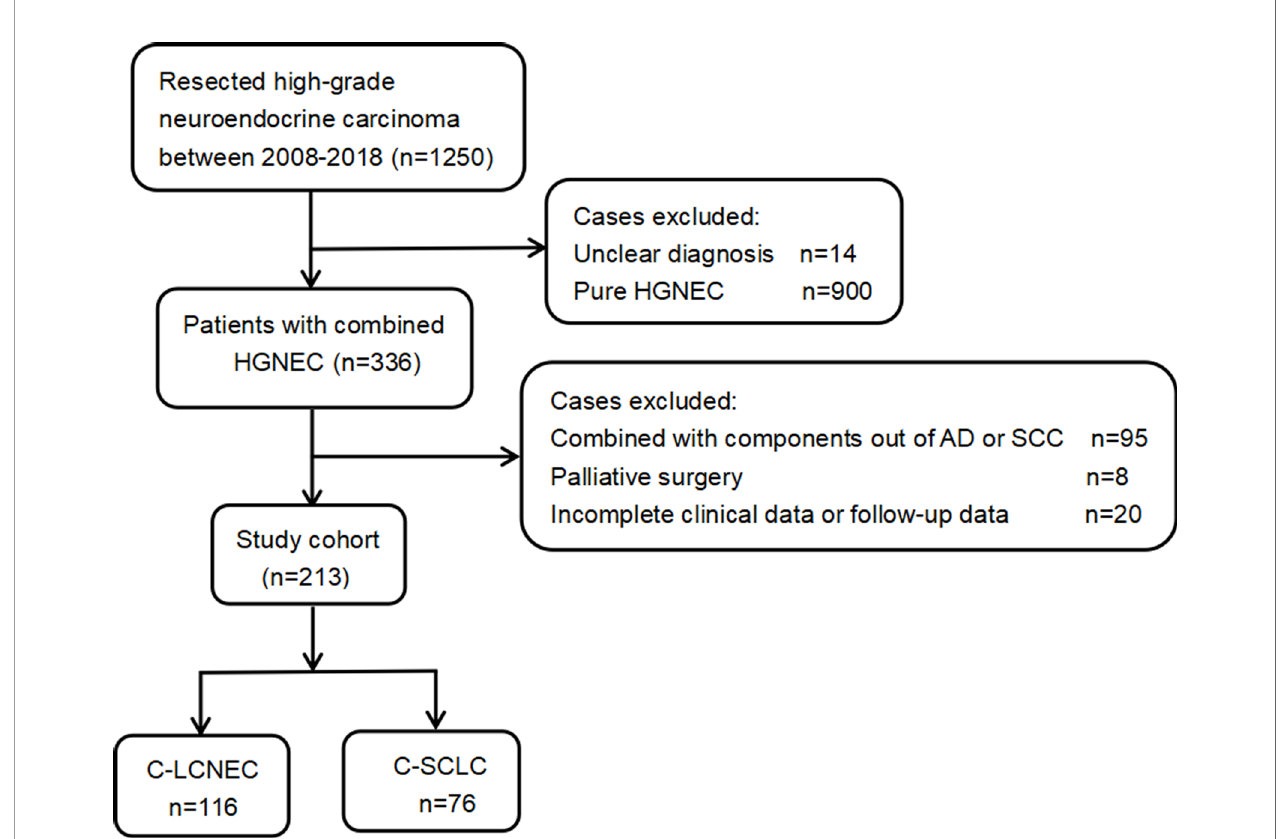
FIGURE 1 | The work fl ow of patient inclusion for the present